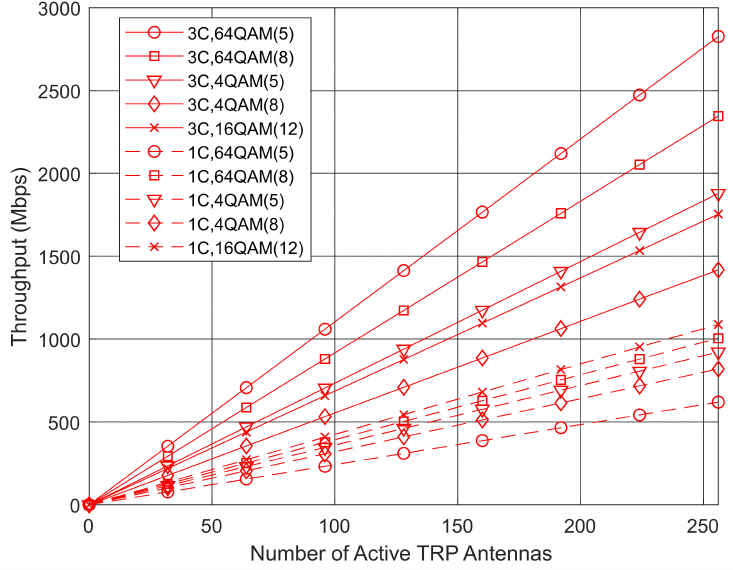
Figure 11. Throughput vs. number of active TRP antennas, for UMi scenario, N rx = 5, for two C-RAN cluster sizes, modulations and numbers of antennas per user, namely with N tx /N u = 5, 64QAM(5) and 4QAM(5); with N tx /N u = 8, 64QAM(8) and 4QAM(8); and with N tx /N u = 12,